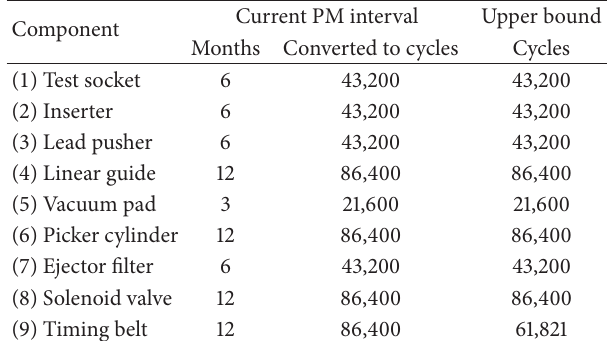
Table 10: Upper bound setting for each